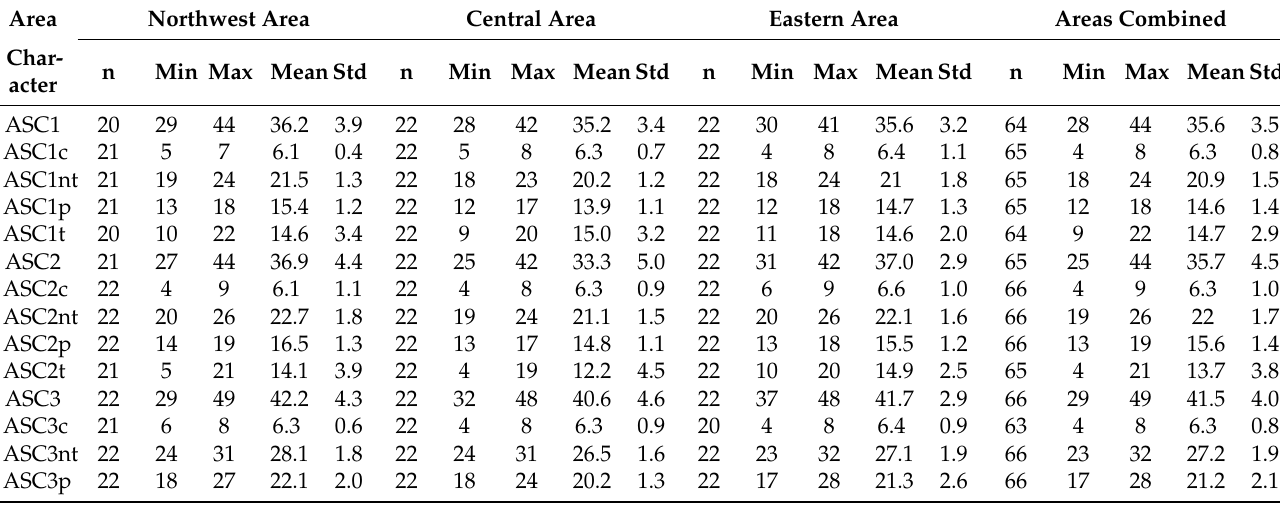
Table A4. Meristic counts for male Sepia typica. Sample size ( n ), minimum (Min), maximum (Max), arithmetic mean (Mean) and standard deviation of the mean (Std) are presented by region and for all regions combined for each character (See Table A1 for character